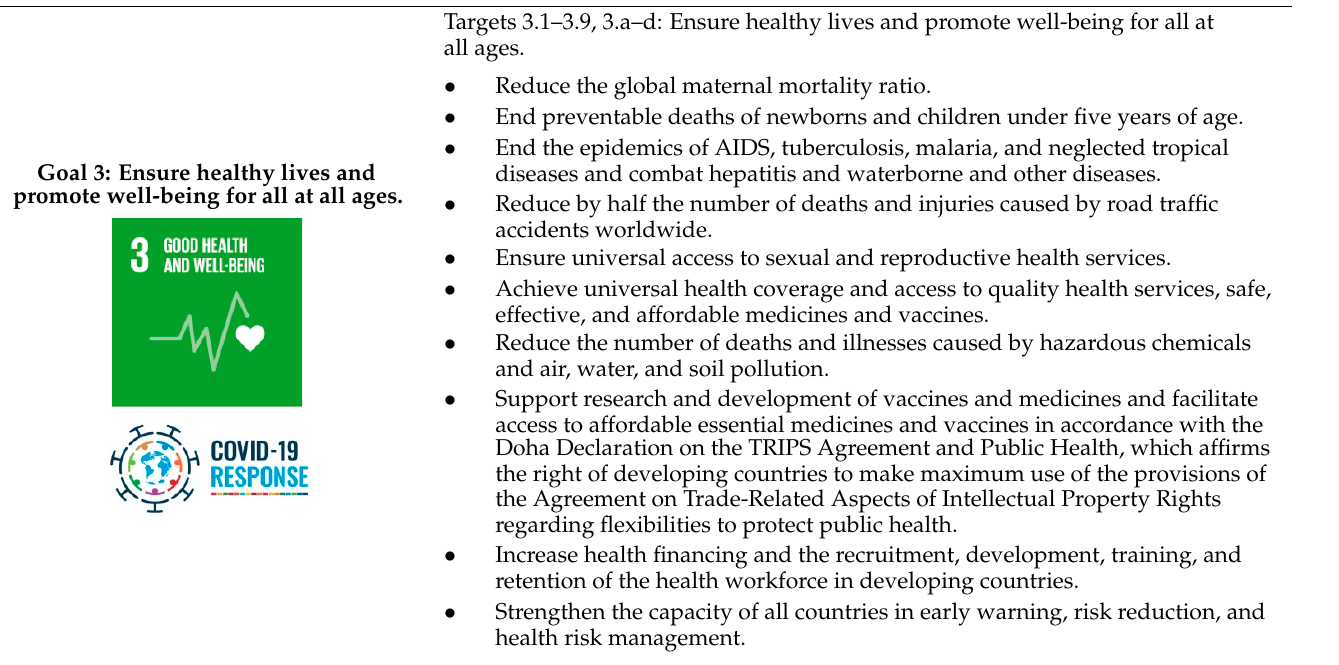
Table 5. Impact of the Sustainable Development Goals on IoT applications for improving health and the environment. SDGs Targets Goals and Application to IoT Systems